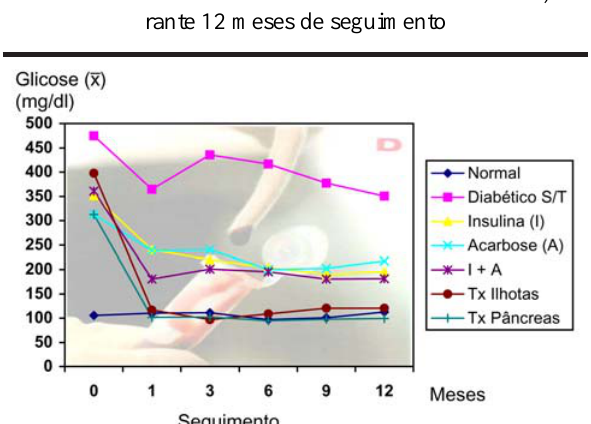
FIGURA 6 - Médias da glicemia (ml/dl) de animais normais, diabéticos não tratados e diabéticos tratados com cinco diferentes tratamentos, durante 12 meses de seguimento